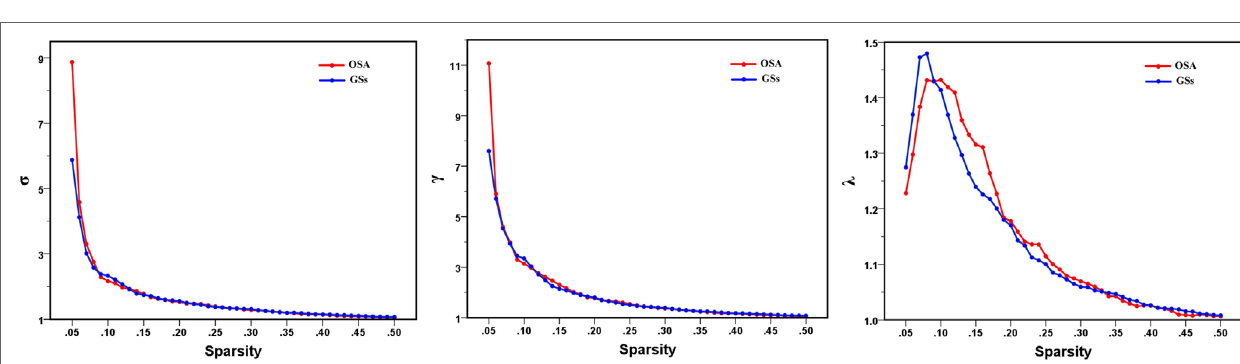
FigUre 4 | Small-world parameters of default mode network in patients with obstructive sleep apnea (OSA) and good sleepers (GSs). Graphs show that in the defined wide range of thresholds, both the patients with OSA and GSs exhibited normalized clustering coefficient ( γ ) obviously larger than 1, normalized path lengths ( λ ) approximately equal to 1, and small-worldness ( σ ) larger than 1, suggesting that both OSA patients and GSs show typical small-world topology.